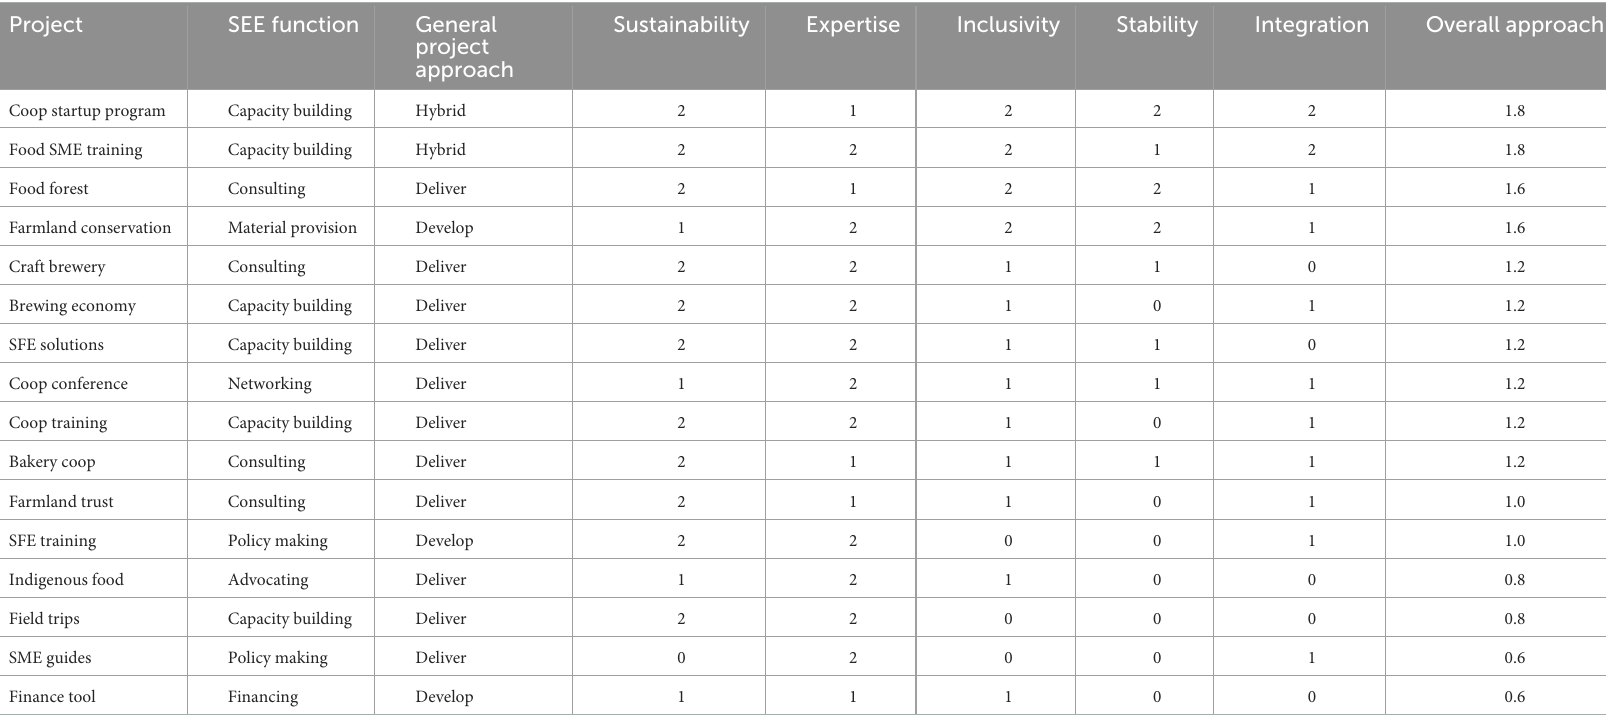
TABLE 5 Summary appraisal of project approach across five performance criterion (0 = weak, 1 = medium, 2 = strong) and overall approach (mean).